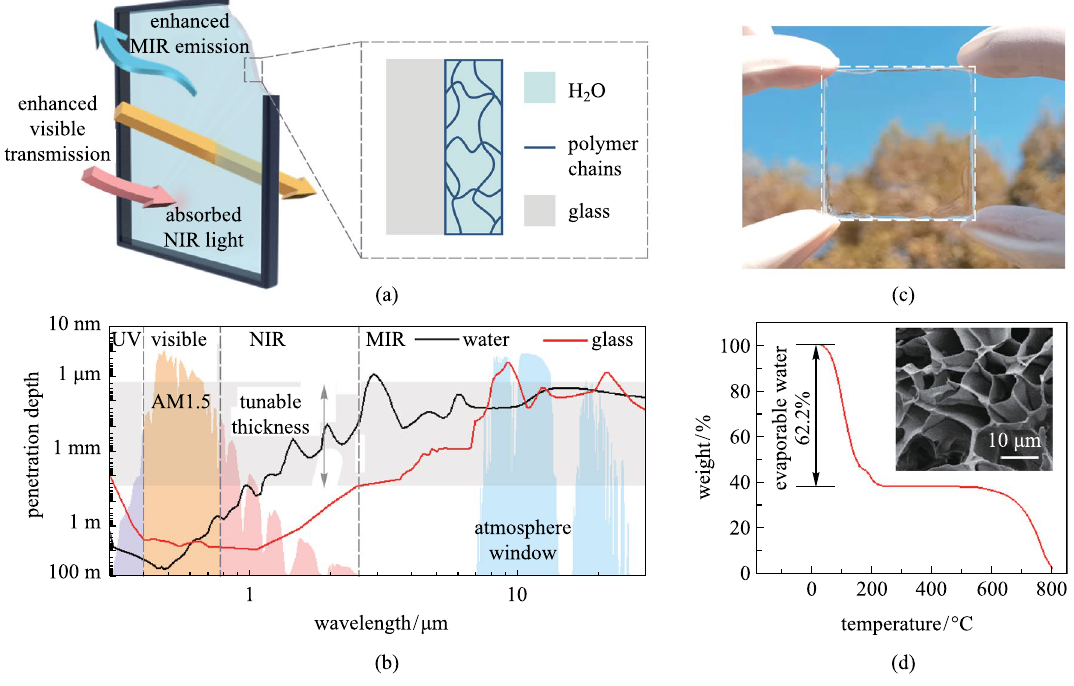
Structure design and working principle of the hydrogel-glass. a Schematical structure of the hydrogel-glass with the functions of enhanced visible transmission, absorbed NIR light and enhanced MIR emission. b Calculated photon penetration depths for liquid water and traditional silica glass. c Photograph of the fabricated hydrogel-glass. d Thermogravimetric analysis of the hydrogel. Inset is the SEM image of the freeze-dried